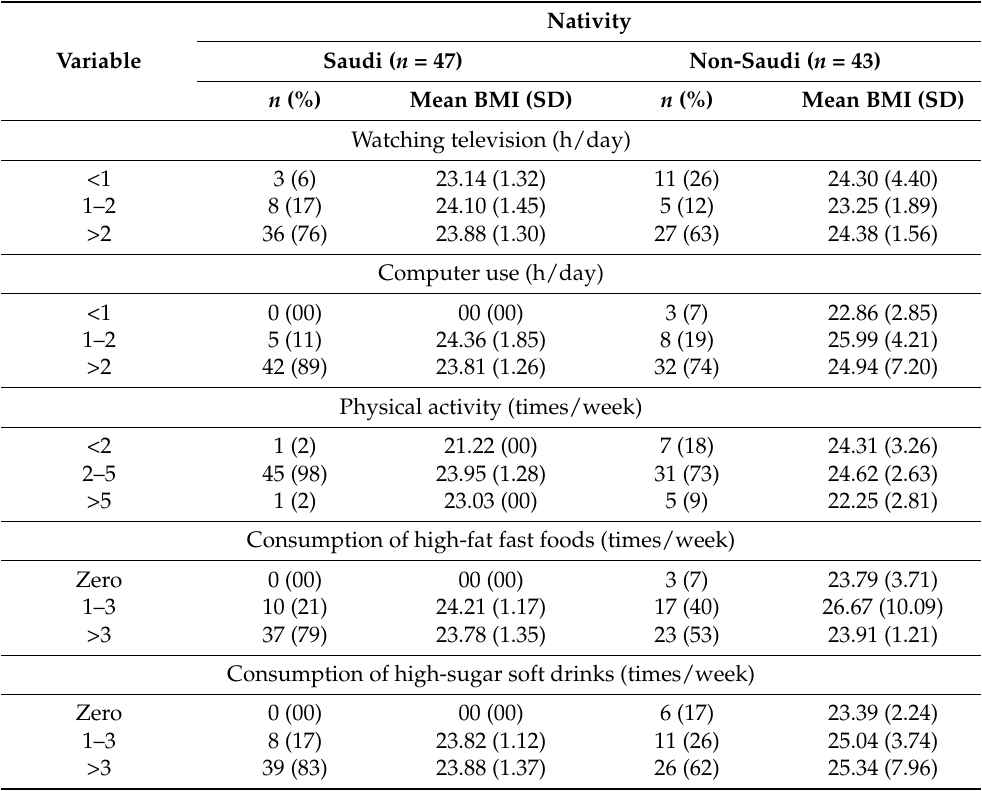
Table 4. Nativity based variations in lifestyle behaviors (watching television, computer use, physical activity, and food preferences) and their relationships to mean body mass index (BMI) among